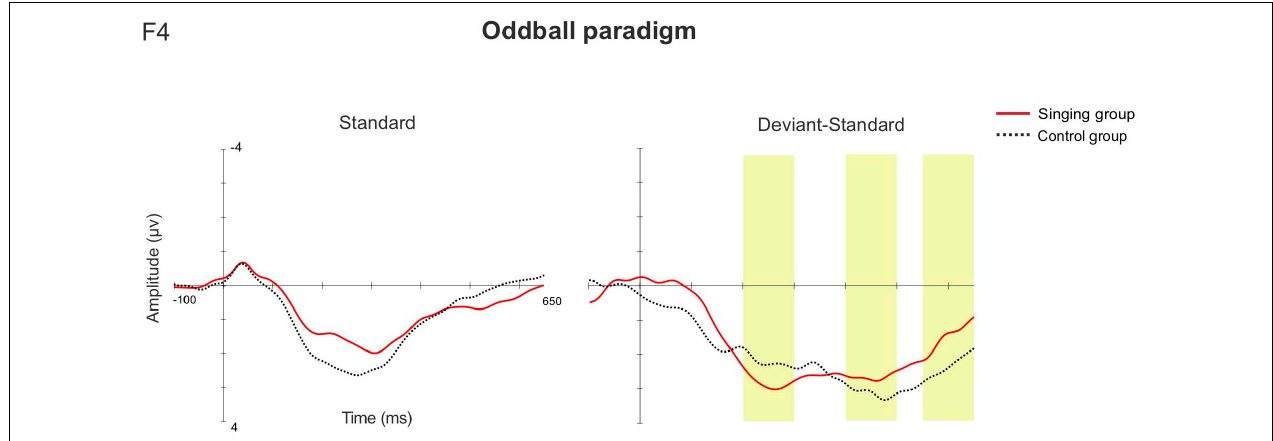
FIGURE 5 | The AERP waveforms for the standard stimulus, and the standard-subtracted waveforms for the deviant stimulus between the singing intervention and control group in the oddball paradigm (F4). The yellow bars highlight the examined latency windows 200–300, 400–500, and 550–650 ms.